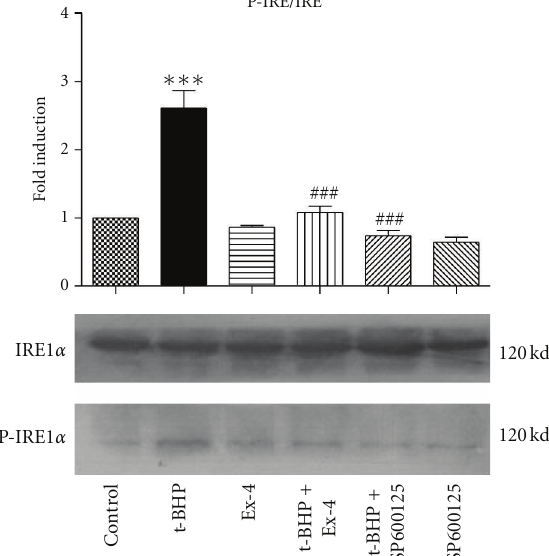
Figure 3: Exendin-4 inhibits t-BHP-induced increase in IRE1. MIN6 cells were preincubated with exendin-4 (100nM) or with SP600125 (10nM) for 18 h and then exposed to t-BHP (25 μ M) for 1h. Representative western blot images revealed the expression levels of phospho-IRE and total IRE. The histogram shows the quantification of the protein data. Levels of phosphorylated protein were normalized to the levels of total protein and expressed as the relative fold change compared to the control samples. Values correspond to the mean ± SD ( n = 3). ∗∗∗ P < 0 . 001 compared with the control group; ### P < 0 . 001 versus t-BHP